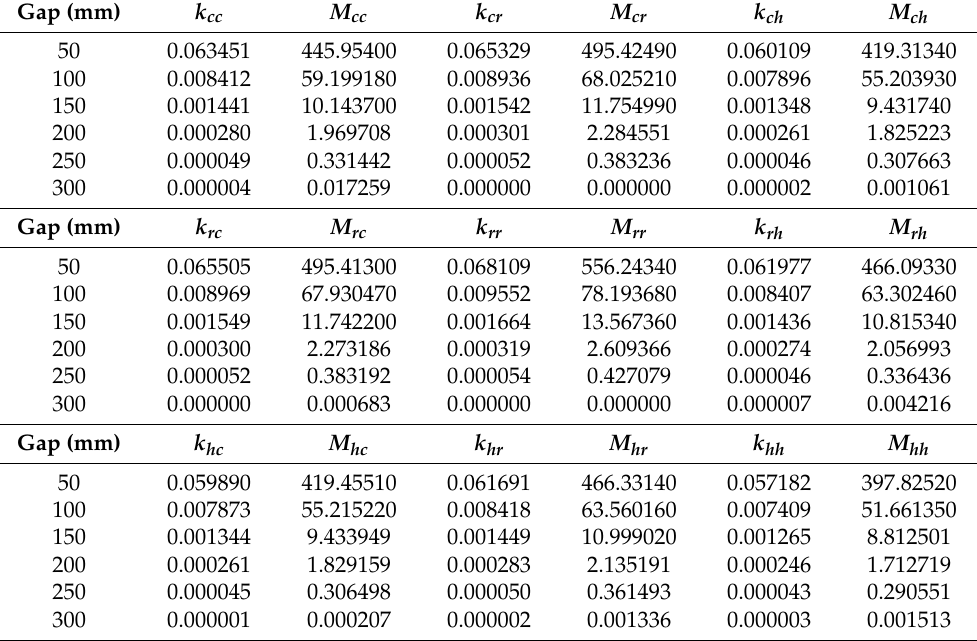
Table 14. The simulation results of coupling coefficient and mutual inductance for the nine models. Gap